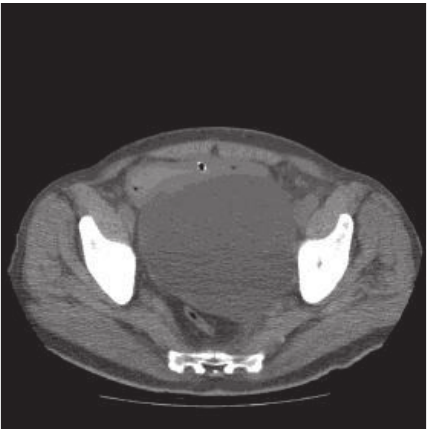
Figure 4: Abdominal CT scan: retrovesical 14 × 14 × 12cm cystic mass and bilateral obstructive uropathy.